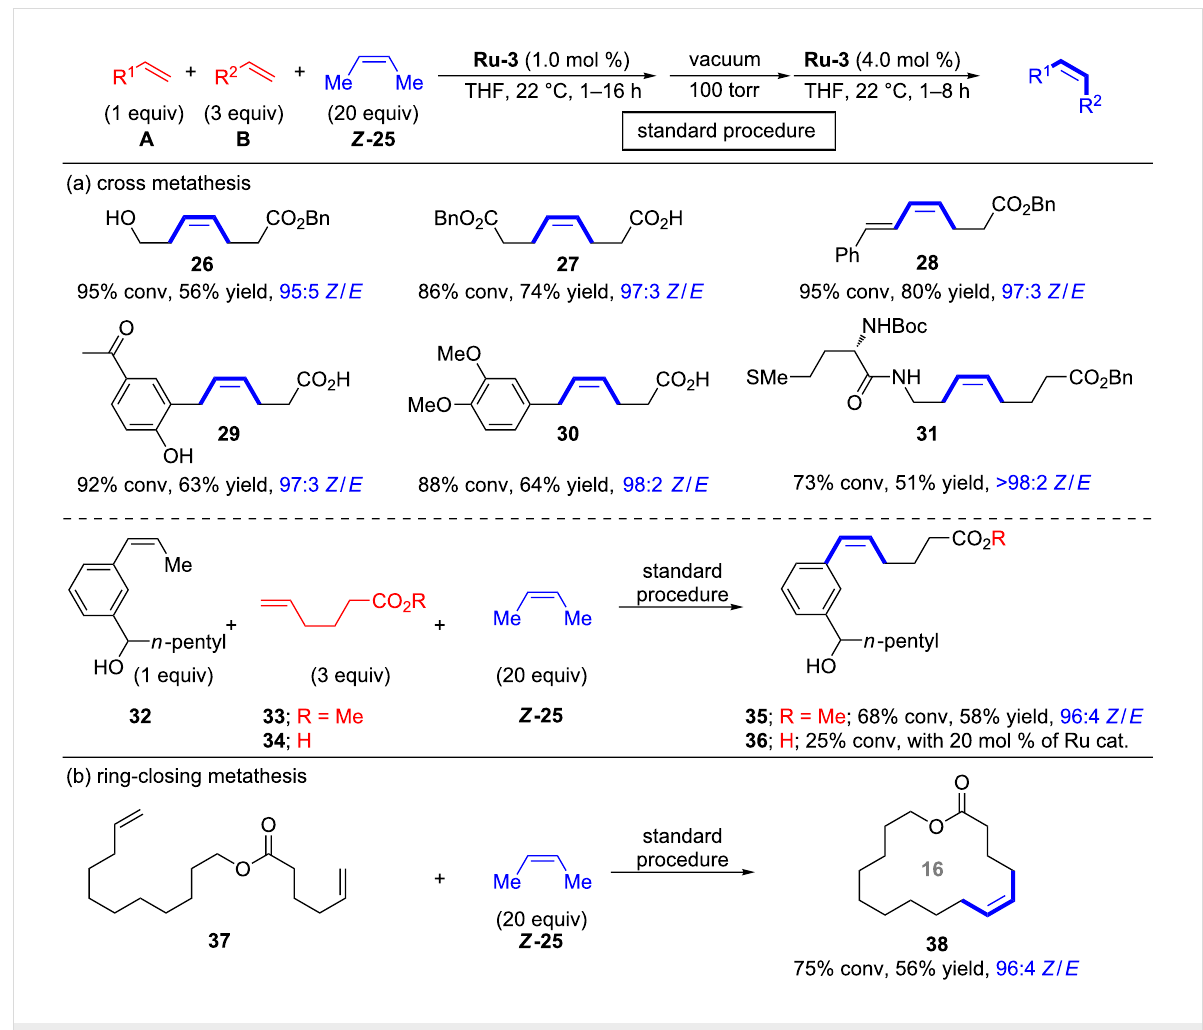
Scheme 6: Stereoretentive cross-metathesis with ( Z )-butene ( Z -25 ) as in situ methylene capping agent; selected applications.